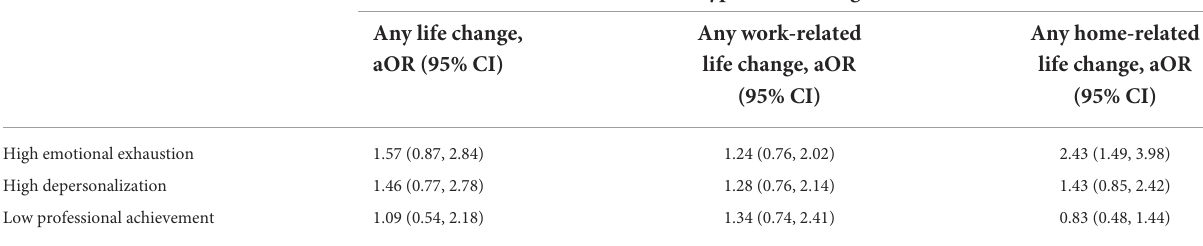
TABLE 3 Adjusted odds ratios (aOR) of burnout associated with life changes due to COVID-19 *